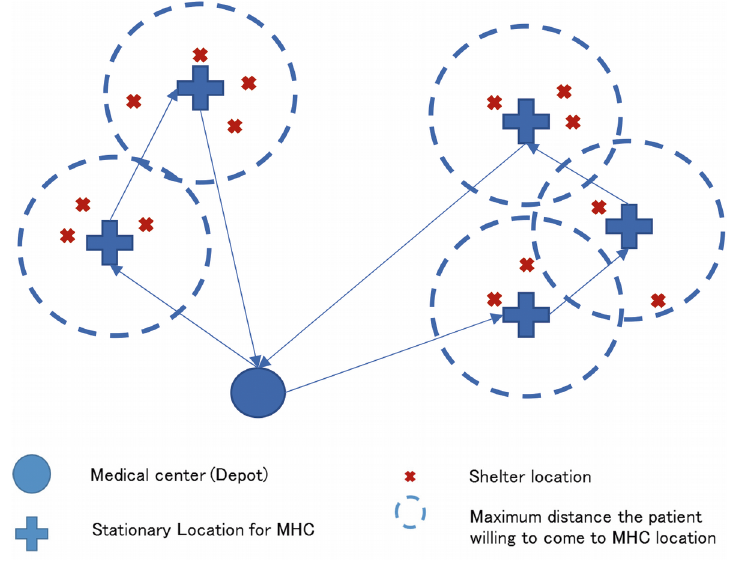
Figure 1. Mobile Health Clinic Routing